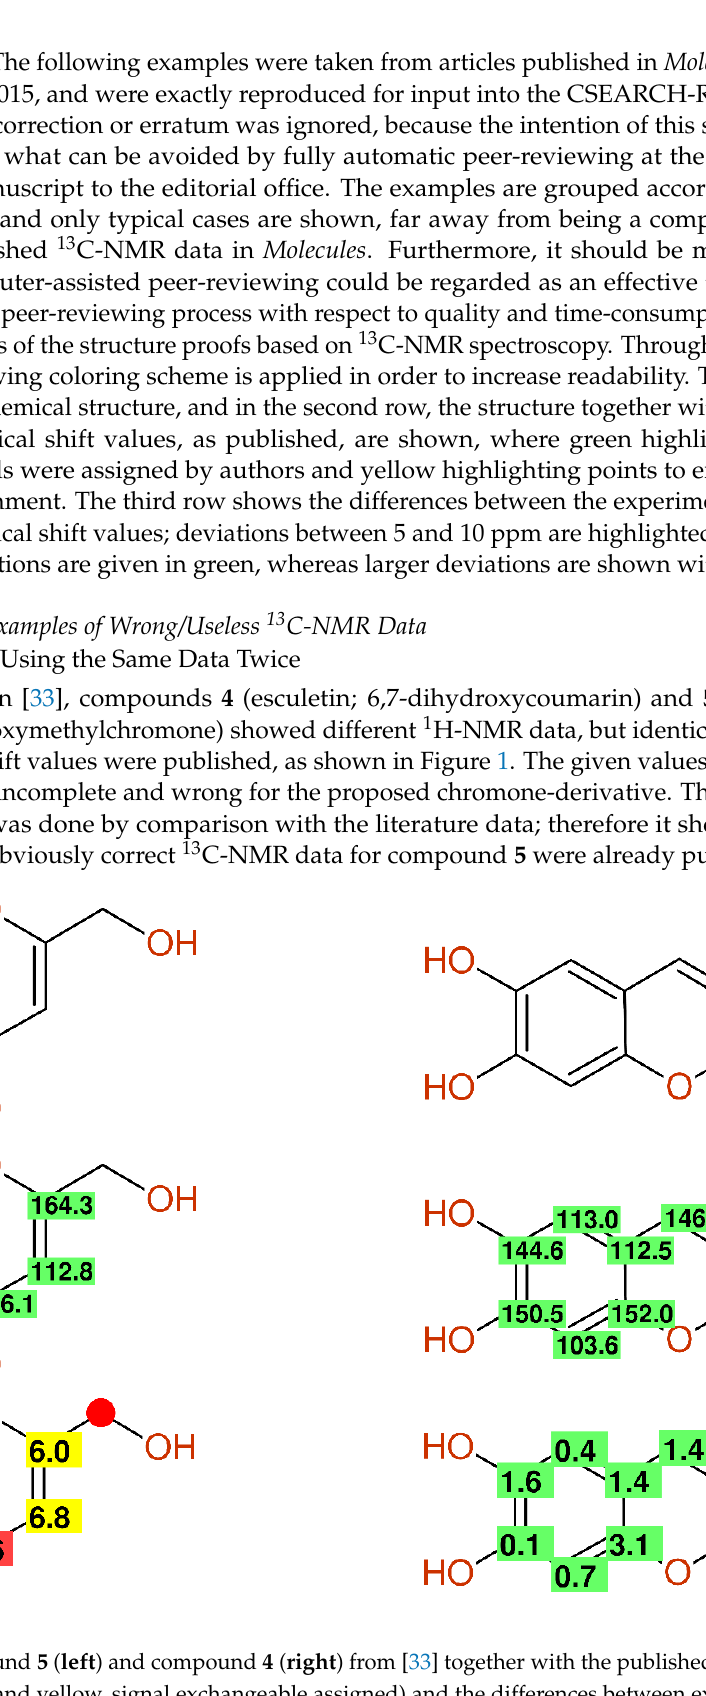
Table 1. Comparison of the quality of 13 C-NMR data published in Molecules (MOL) versus Chemical and Pharmaceutical Bulletin (CPB), Fitoterapia (FT), Journal of Natural Products (JNP), Phytochemistry (PC), and Planta Medica (PM).